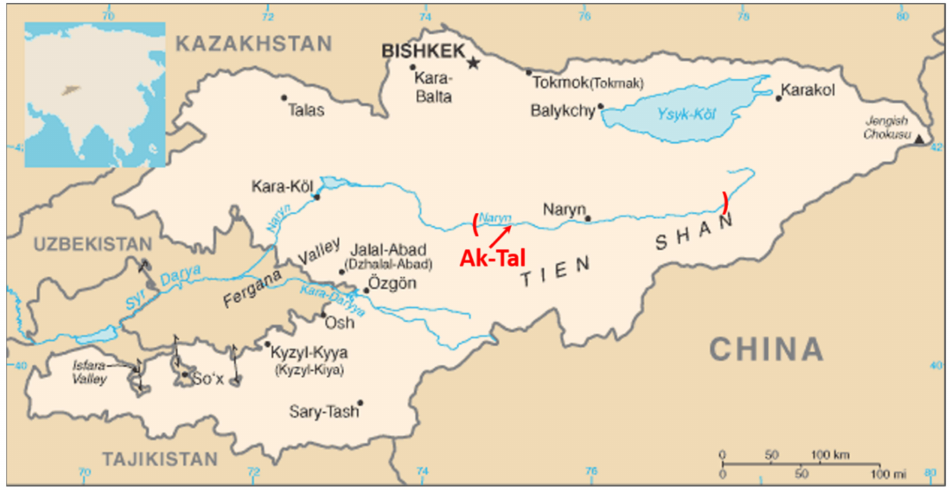
Figure 1. The Naryn River in Kyrgyzstan; the braided section harbouring most of its riparian forests is indicated by ( ); the position of the main research site, Ak-Tal Village, is indicated by an arrow (adapted from